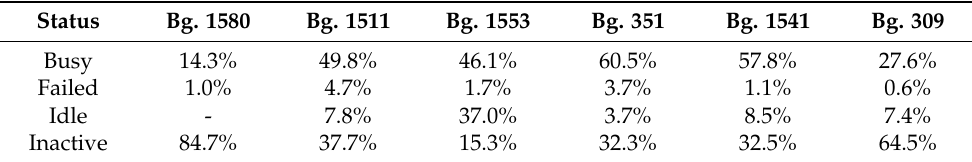
Table 7. Utilization predicted by the simulation model.